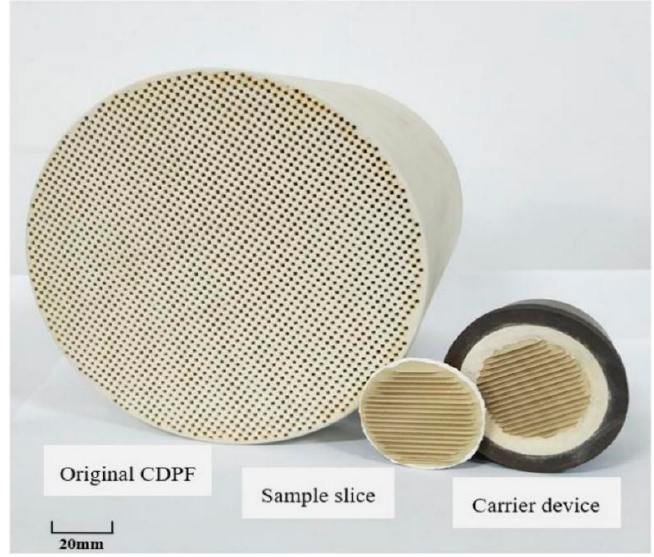
Figure 7. The original CDPF, sample slice, and carrier device [91].